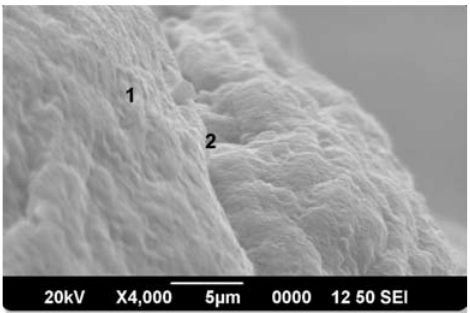
Fig. 1. sEm image of squamous epithelial cells of the ovary. sEm x 4000 1. Squamous epithelial cells 2. Ridges